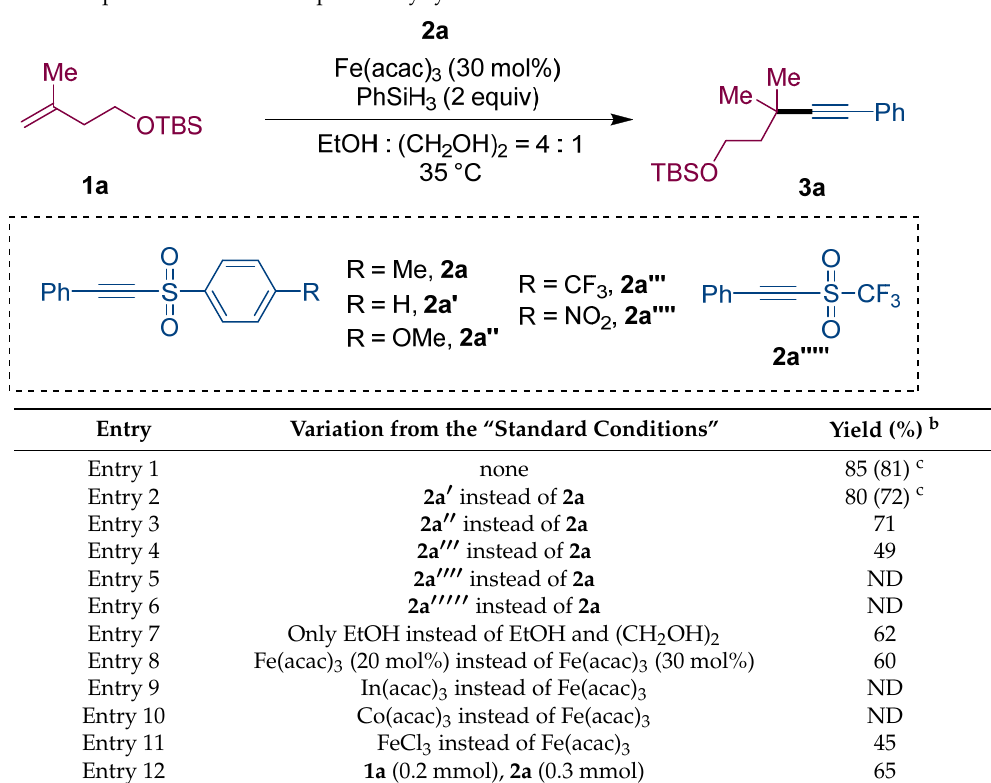
Table 1. Optimization of SOMOphilic alkynylation of alkenes a .